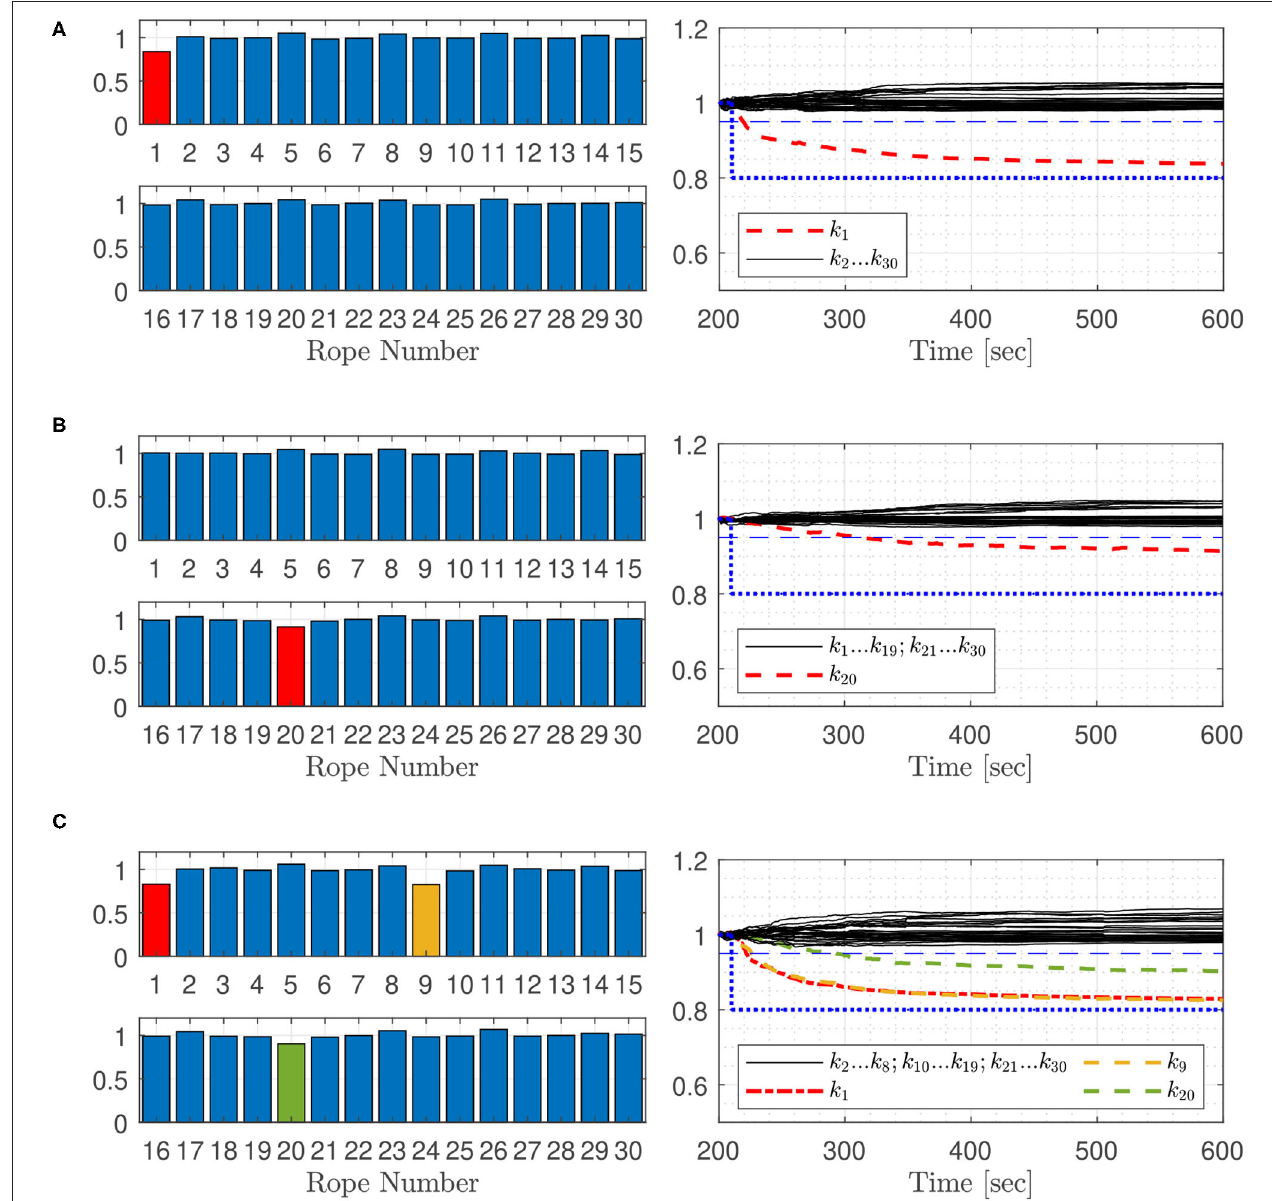
FIGURE 7 | Normalized estimated rope stiffness test cases 1A (A) , 1B (B) , and 1C (C) .